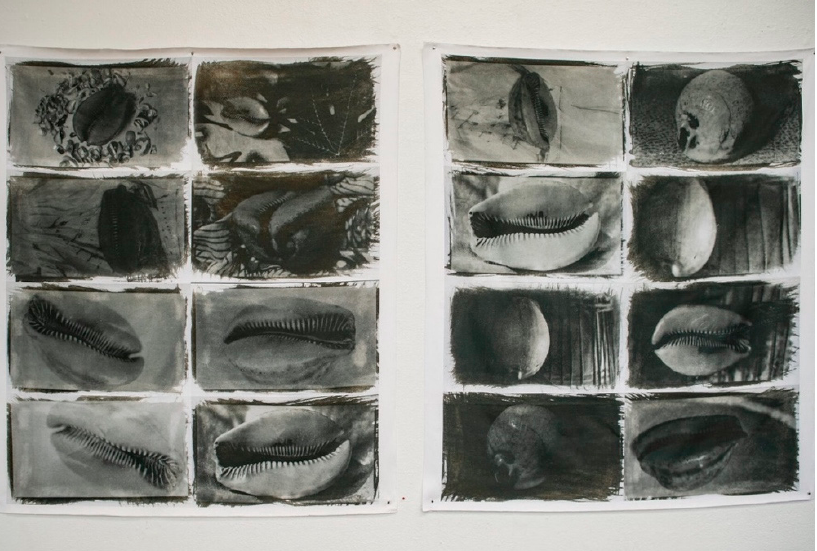
Figure 7. “Cowrie asa asa,” cotton twill and ink jet, 44” × 40, by Jasmine Abena Colgan, an Ameri-Ghanian artist, educator, and scholar from her series “Human Currency”, which explores the connection between the cowrie and slave trades in West Africa. To create the artwork, Colgan photographed a cowrie shell and printed it in platinum and palladium photographic solution on cotton paper. Each image is portrayed in a saturated monochromatic tile which narrates artistic rituals and cultural traditions. The prints were scanned and then printed onto a cotton fabric. The documented shell is collaged into an ‘asa asa’ and this tradition migrated over the Atlantic Ocean into what is called a quilt.